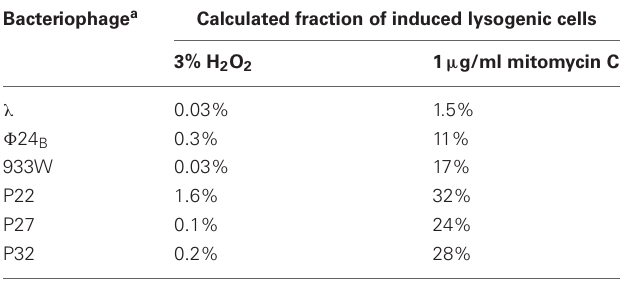
Table 1 | Efficiency of prophage induction after treatment of E. coli lysogenic cells with various